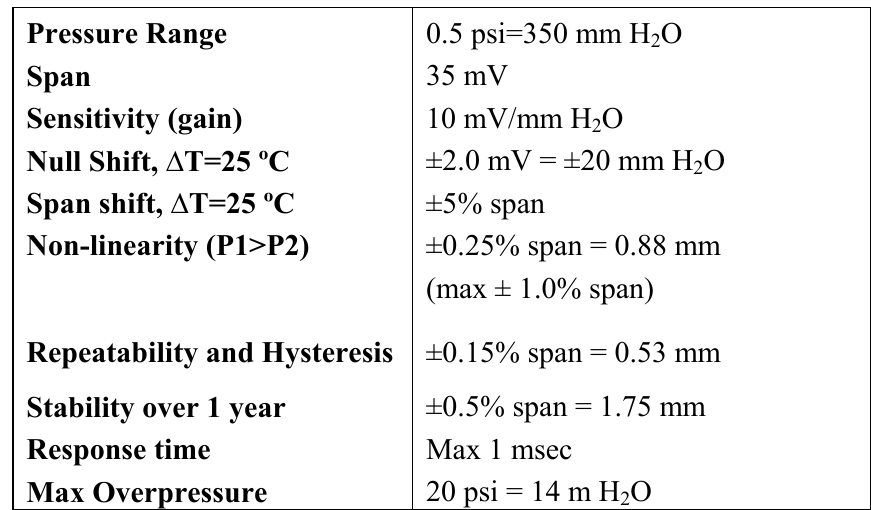
Table 1. Specifications of 24PC series (Differential, Unamplified, Non-compensated pressure sensors) published by Honeywell. Performance characteristics at 10.0 ± 0.01 VDC Excitation 25ºC. All values are typical unless otherwise